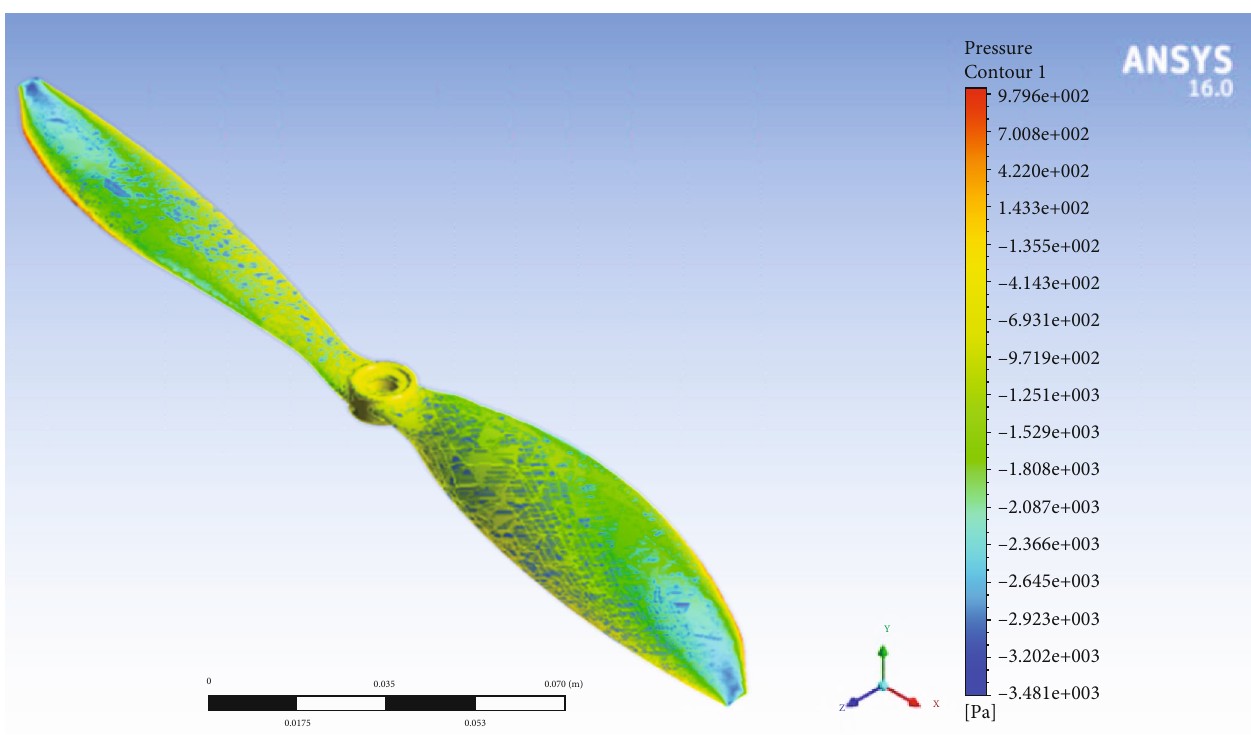
Figure 20: Pressure contour at -25 ° C